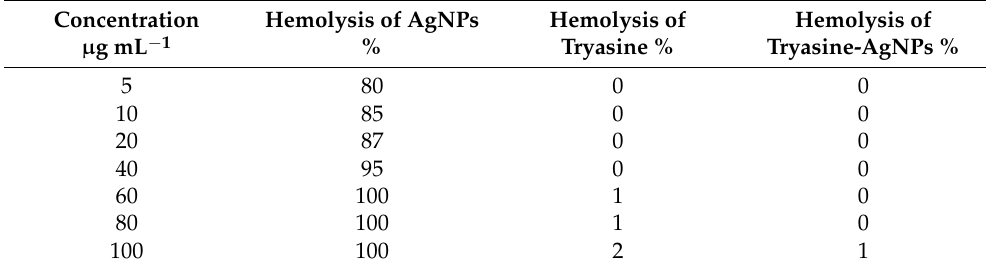
Table 5. The in vitro hemolysis activity of Tryasine-AgNPs in human erythrocytes.